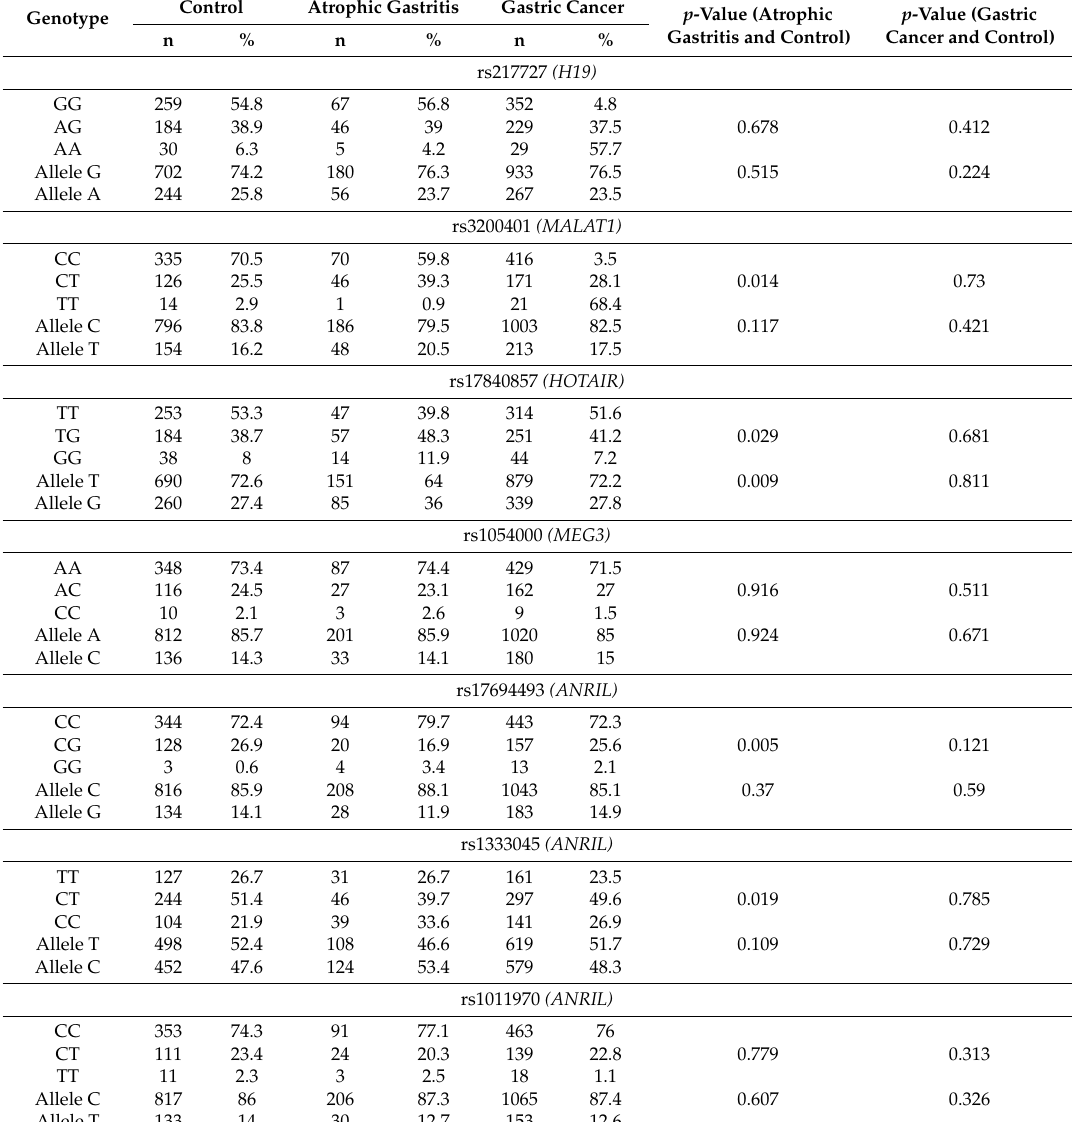
Table 3. Genotype and allele frequencies in control group and atrophic gastritis and gastric cancer